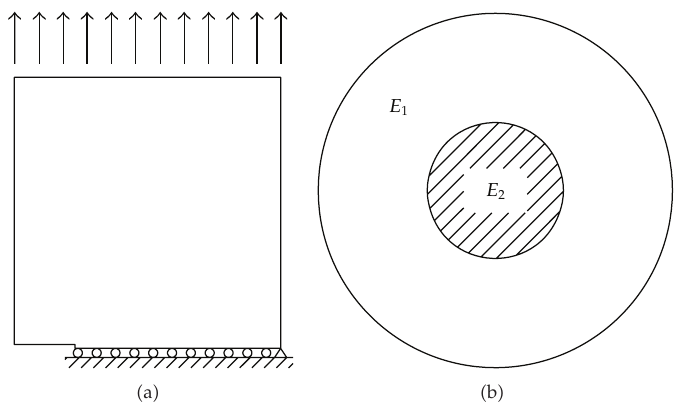
Figure 10: (cid:5) a (cid:6) A plate with mode I crack and (cid:5) b (cid:6) a circulate cell with an inclusion.